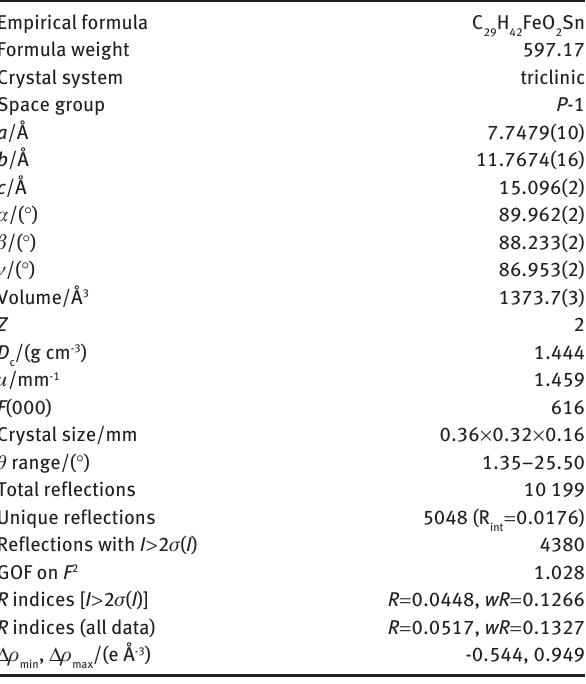
Table 3 Crystallographic and refinement data of 1 . Empirical